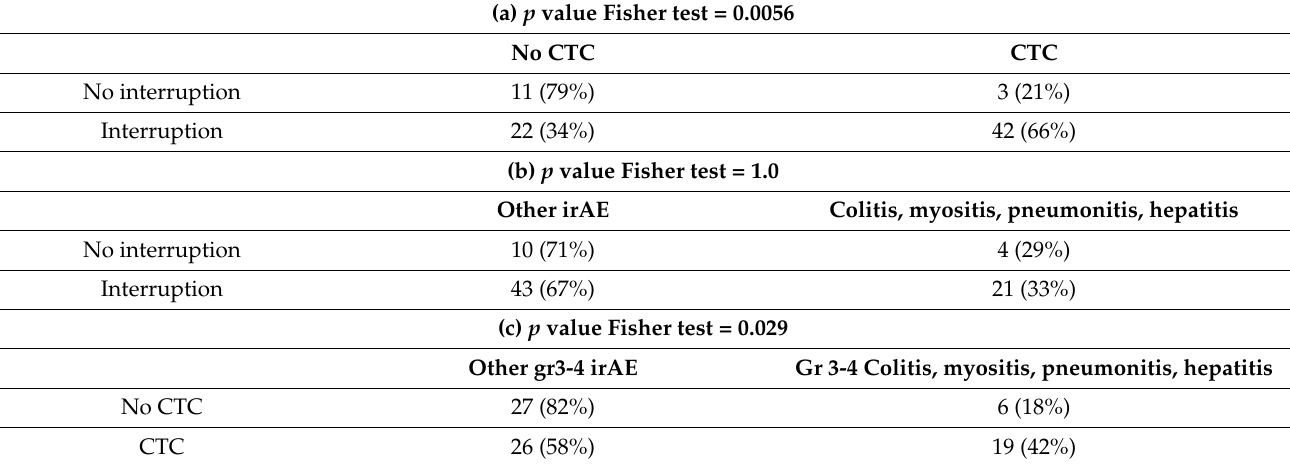
Table 5. Correlation between the type of irAEs and their management. (a) Correlation between interruption if ICI and introduction of glucocorticoids. (b) Correlation between interruption of ICI and the type of irAEs. (c) Correlation between the type of irAEs and introduction of glucocorticoids. irAEs = immune-related adverse events;. ICI = immune check-point inhibitors; CTC =